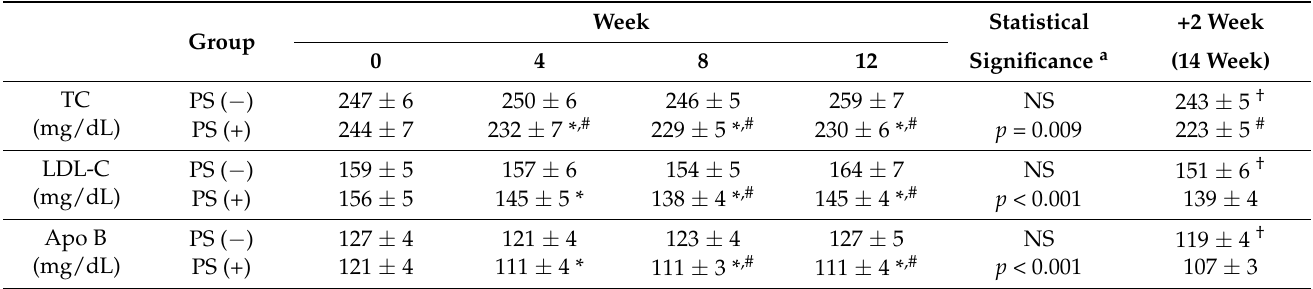
Table 2. Effects of phytosterol-containing mayonnaise-type dressing material on the normo- and mildly hypercholesterolemia (serum total cholesterol ≥ 200 mg/dL, and LDL-cholesterol ≥ 120 mg/dL).